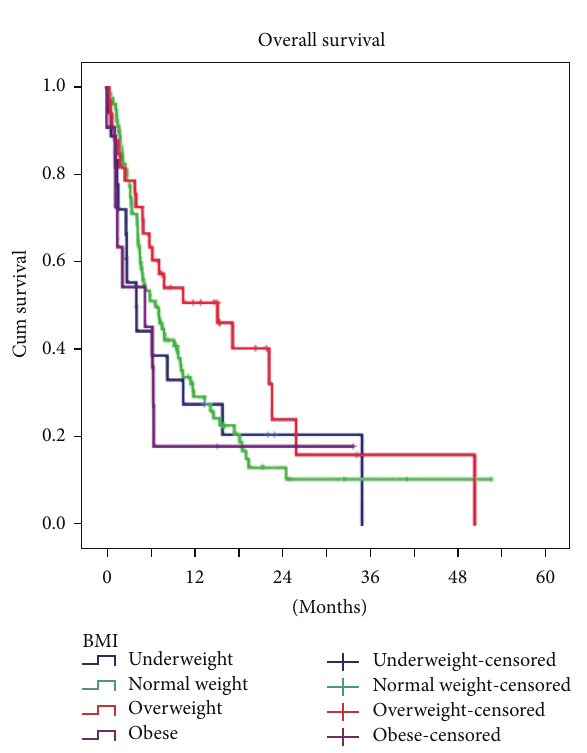
Figure 1: Relation between body mass index and overall survival in patients with gastric cancer (Kaplan-Meier